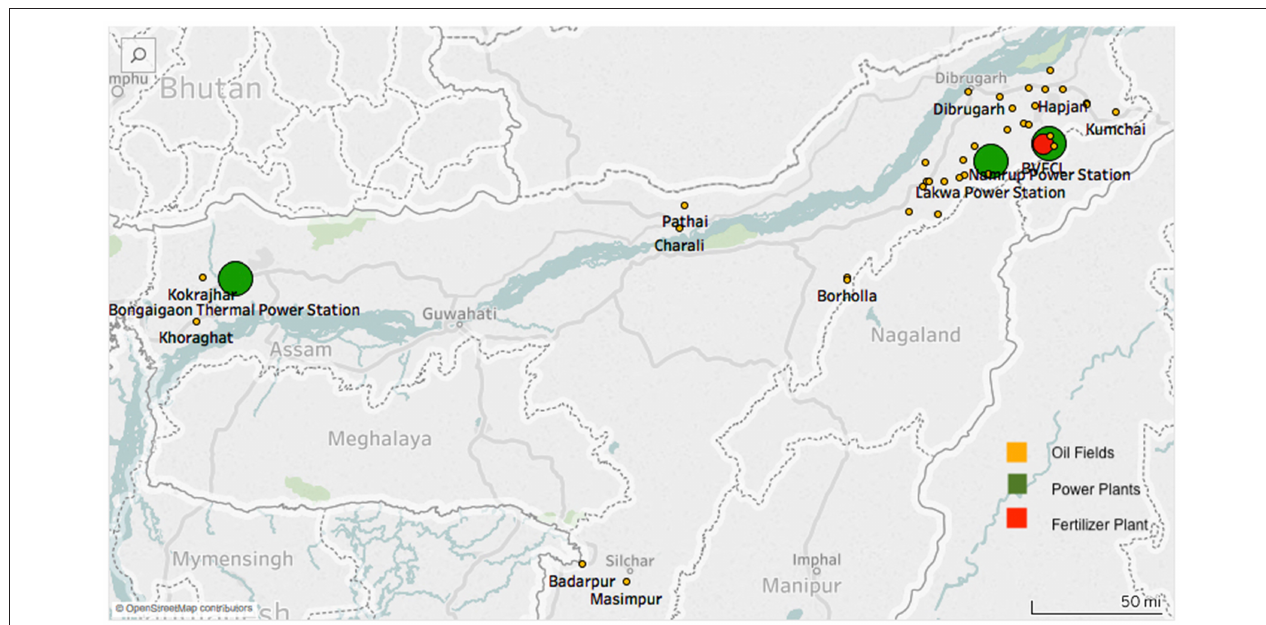
FIGURE 6 | Major oil fields, power plants and fertilizer plant in Assam. Data Source: Brahmaputra Valley Fertilizer Corporation Ltd., Assam Power Generation Corporation Ltd., NTPC Ltd., Directorate General of Hydrocarbons, Ministry of Petroleum & Natural Gas, Govt. of India; Government of Assam (Brahmaputra Valley Fertilizer Corporation Limited, 2016; APGCL, 2017; NTPC, 2017; Directorate General of Hydrocarbon,